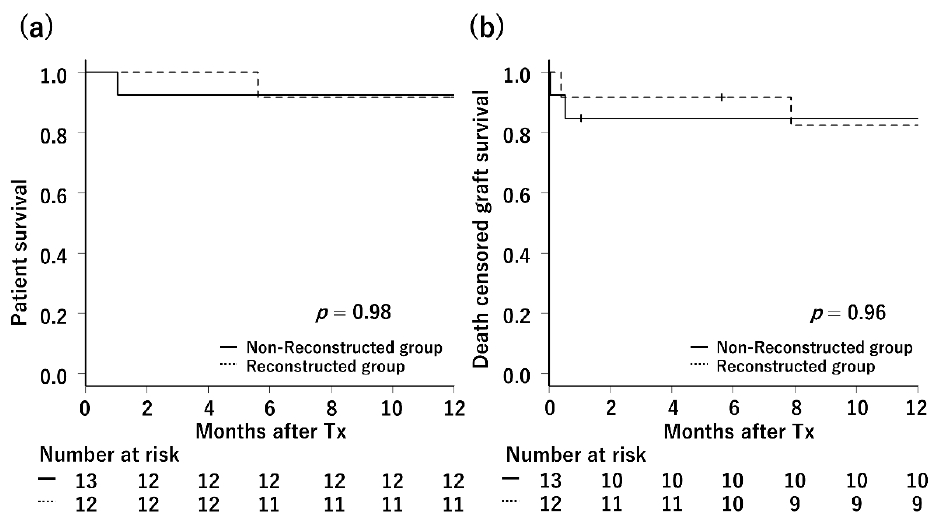
Figure 3. Kaplan–Meier curve for patient survival and graft survival. ( a ) One-year patient sur- vival: The 1-year patient survival rates were 92.3% and 91.7% in the non-reconstructed and recon- structed groups, respectively. There was no significant difference in survival between the two groups. ( b ) One-year graft survival: The 1-year death censored graft survival rates were 83.3% and 82.5% in the non-reconstructed and reconstructed groups, respectively. There was no significant difference.